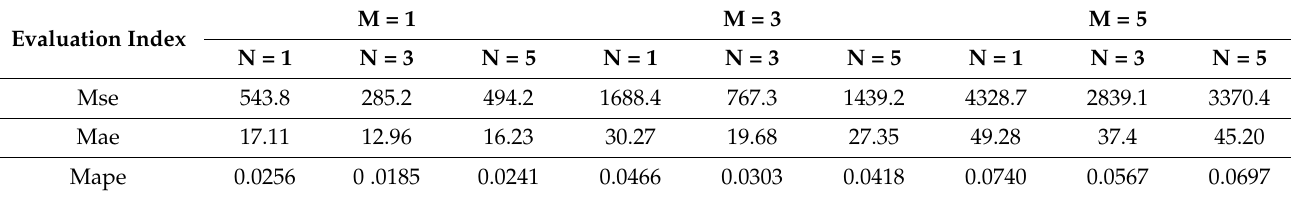
Table 1. The prediction accuracy of N and M under different